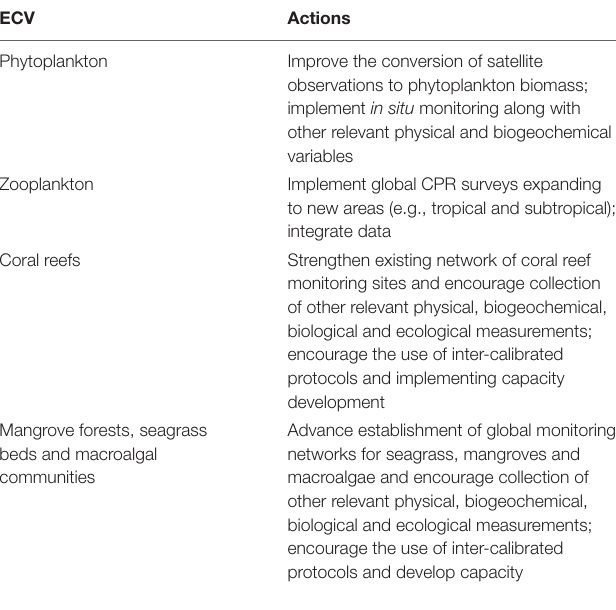
TABLE 2 | Main actions proposed by the GCOS Implementation Plan in relation to the biological ocean ECVs (World Meteorological Organization [WMO], 2016). ECV Actions Phytoplankton Improve the conversion of satellite observations to phytoplankton biomass; implement in situ monitoring along with other relevant physical and biogeochemical